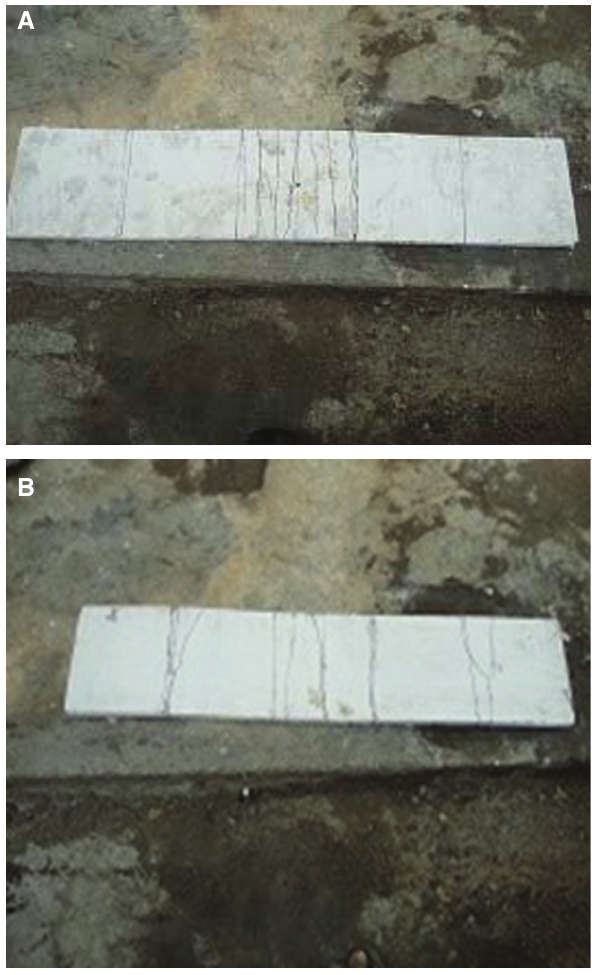
Figure 13 Cracking behavior of (A) 35-mm-thick 12 m GF panels and (B) 35-mm-thick FC panels with five layers of wire